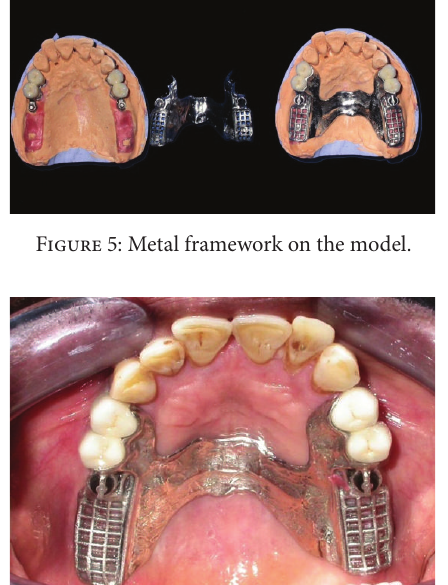
Figure 2: Teeth numbers 14, 14, 24, and 25 prepared to receive porcelain fused to metal crowns.